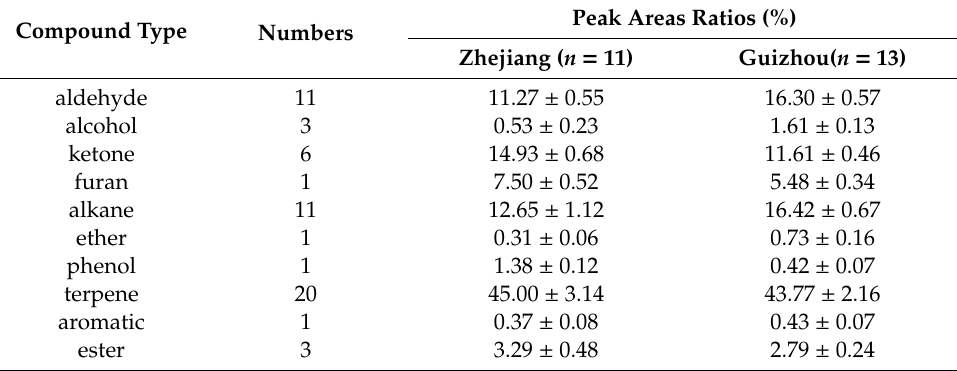
Table 1. Di ff erent compound categories in Selaginella doederleinii from 24